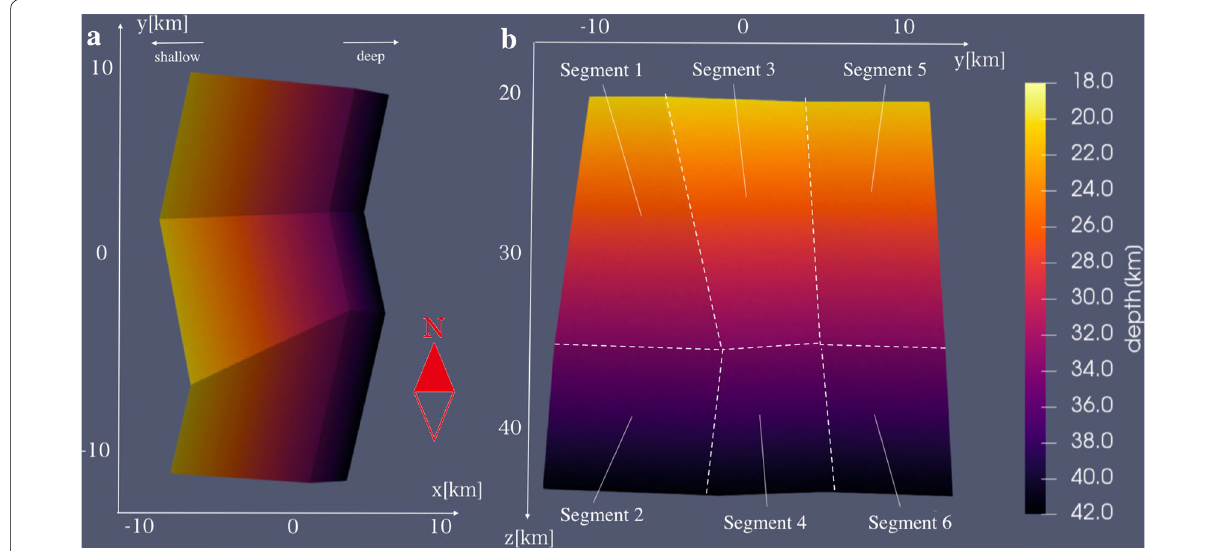
Fig. 2 3-D geometry model of fault surface (view from the top ( a ), and view from the east ( b ))